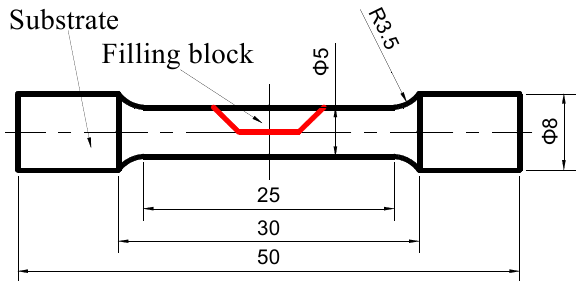
Figure 4. Geometric shape and size of the room-temperature tensile specimen.